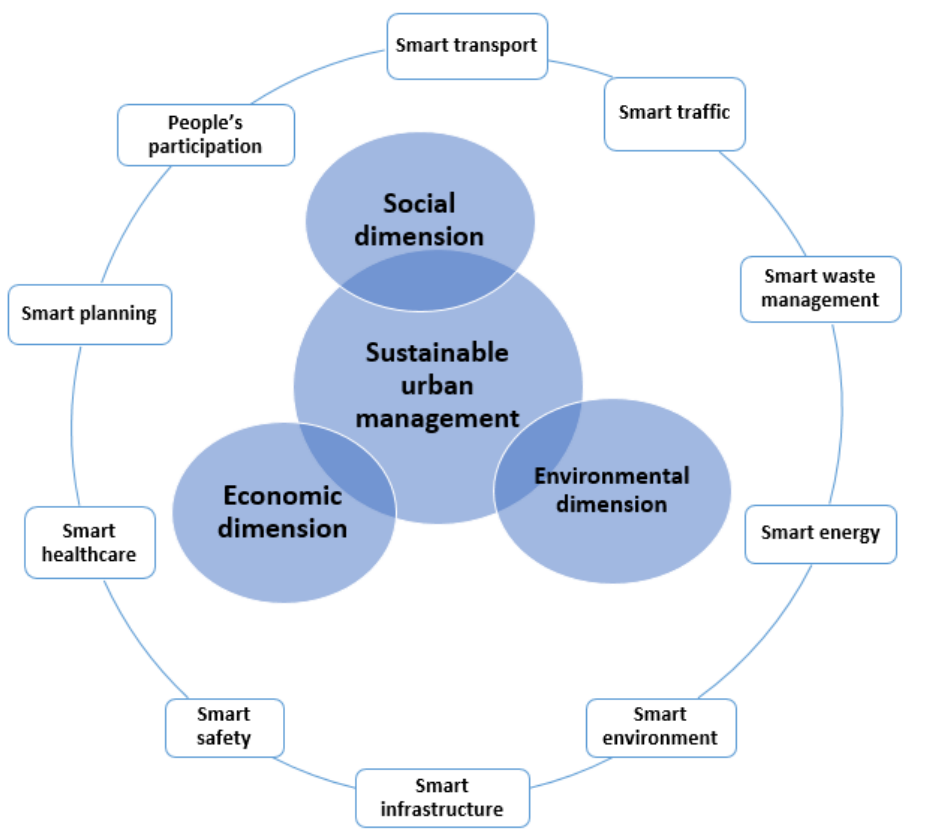
Figure 3. Framework for sustainable urban development.